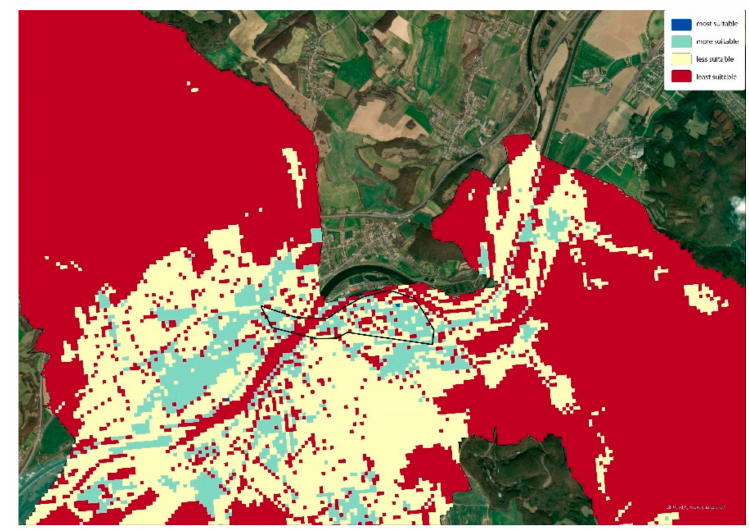
Figure A3. Trencin’s preselected and candidate areas to become positive.